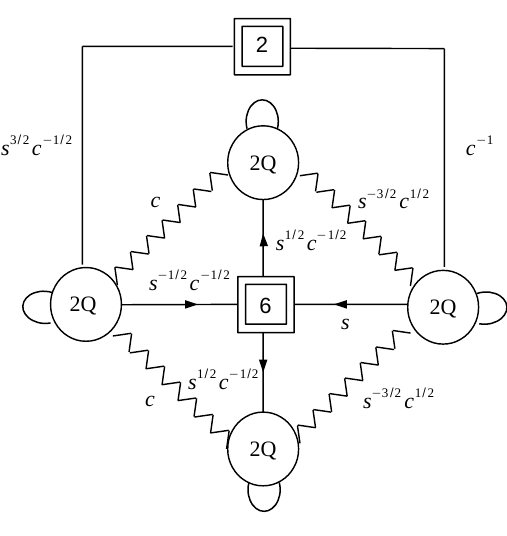
Figure 17: Gluing 2 n ( 1,1,1,1,1,1,0,0 ) tubes we obtain a torus with n units of flux × E × SU ( 2 ) × U ( 1 ) . Here we have n = preserving SU ( 2 ) t 6